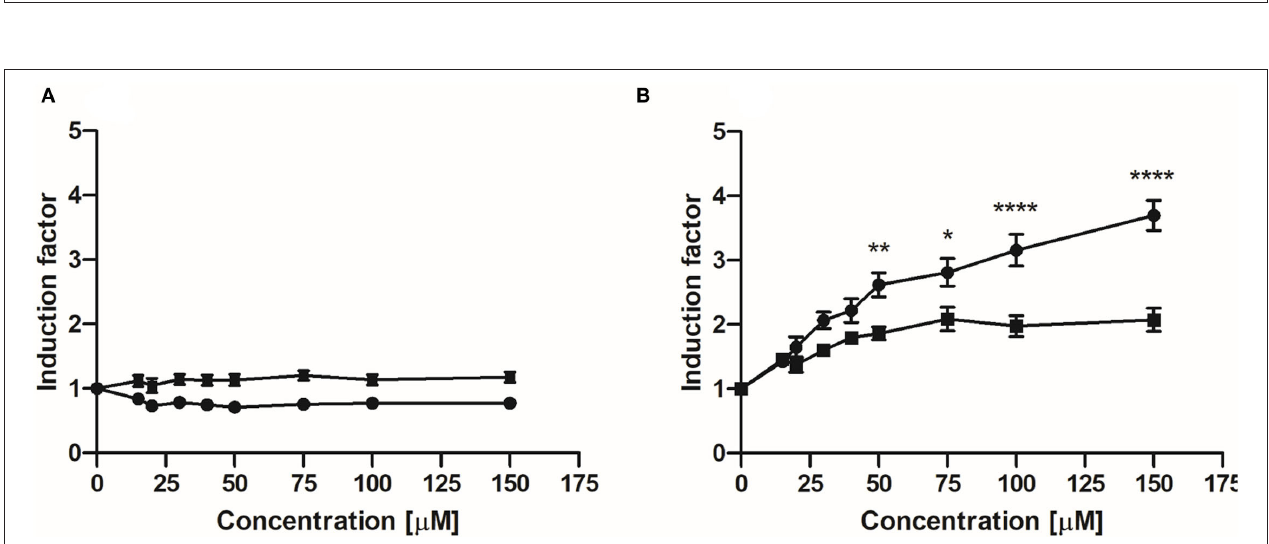
FIGURE 4 | Induction of luciferase expression in U2OS Nrf2 CALUX reporter cells after 24h exposure to EC (A) and 3,4-diHPV (B) . Line curves with square symbols represent co-exposure with 0.5mM l-ascorbic acid (final concentration). While line curves with circular symbols represent exposure with only selected model compounds. Results are presented as mean ± SEM compared with the solvent control, derived from at least three independent experiments. Two-way ANOVA with Bonferroni multiple comparisons were performed to evaluate Nrf2 induction factors induced by 3,4-diHPV, at various concentrations, with and without the presence of 0.5mM l-ascorbic acid. Statistical differences between different treatments are demonstrated (* P < 0.05; **0.001 < P < 0.01; **** P < 0.0001).